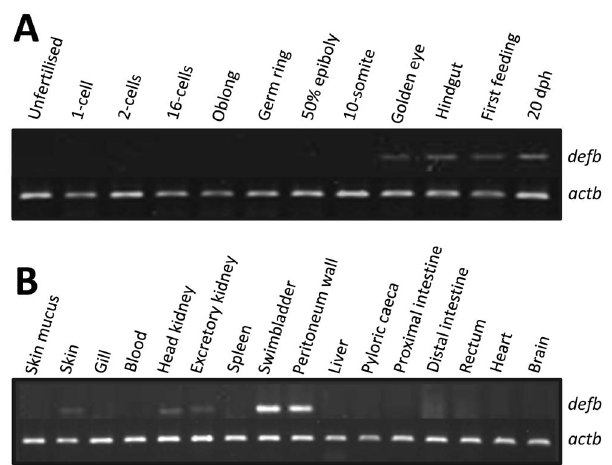
Figure 5. Representative expression pattern of defb (A) during embryonic development and (B) in various juvenile cod tissues, as determined by semi-quantitative RT-PCR. Beta-actin ( actb ) was used as a reference gene. Amplicon sizes are 139 bp and 175 bp for defb and actb , respectively.